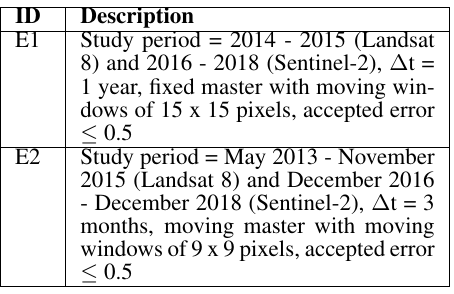
Table 2. Experiments setting summary